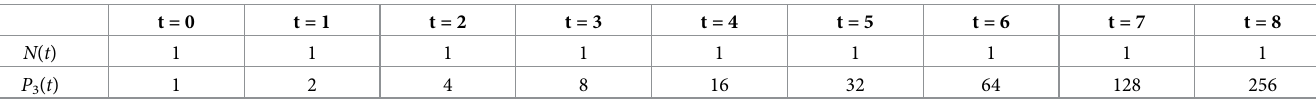
Table 2. Fictional pandemic spread. The variable N ( t ) denotes observed new daily cases, P ( t ) denotes the prediction of new daily cases, and t is the number of days.